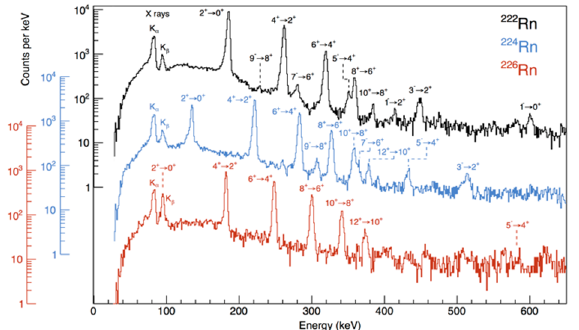
Figure 1. Spectra of γ -rays. The γ -rays were emitted following the bombardment of 120 Sn targets by 222 Rn (black), 224 Rn (blue), and 226 Rn (red). The γ -rays were corrected for Doppler shift assuming that they are emitted from the scattered projectile. Random coincidences between Miniball and CD detectors have been subtracted. The transitions which give rise to the observed full-energy peaks are labelled by the spin and parity of the initial and final quantum states. The assignments of the transitions from the negative parity states in 224,226 Rn are tentative (see